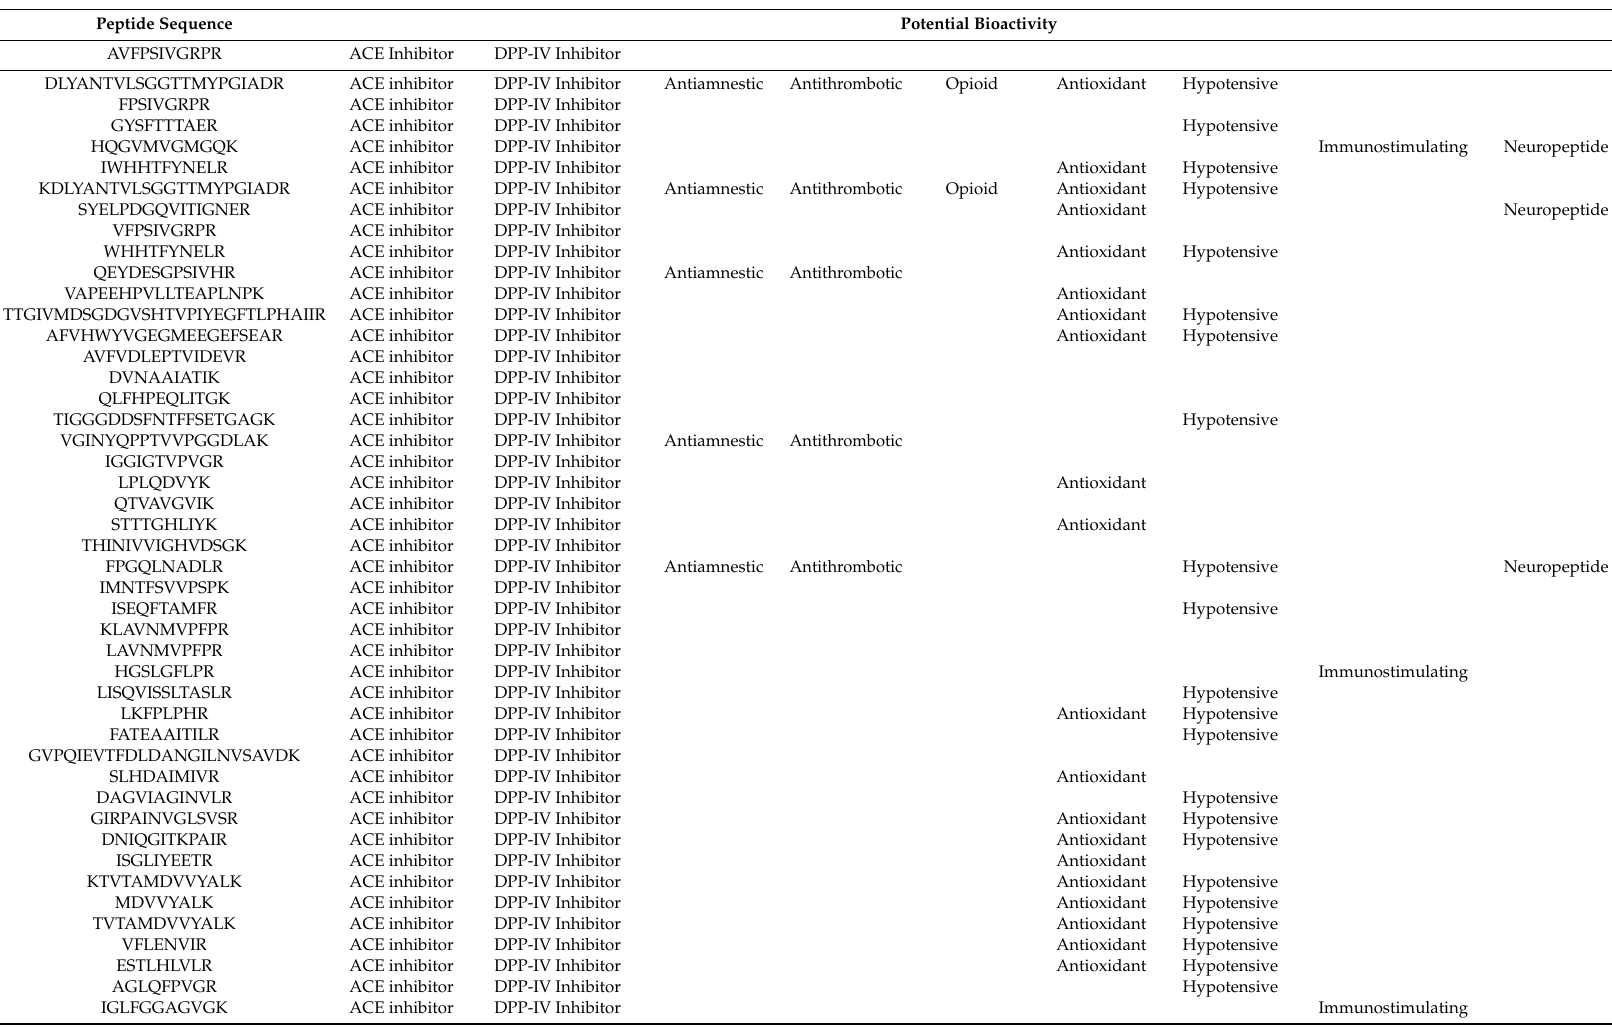
Table 3. Potential peptide bioactivity of hairless canary seed in vitro digestates using